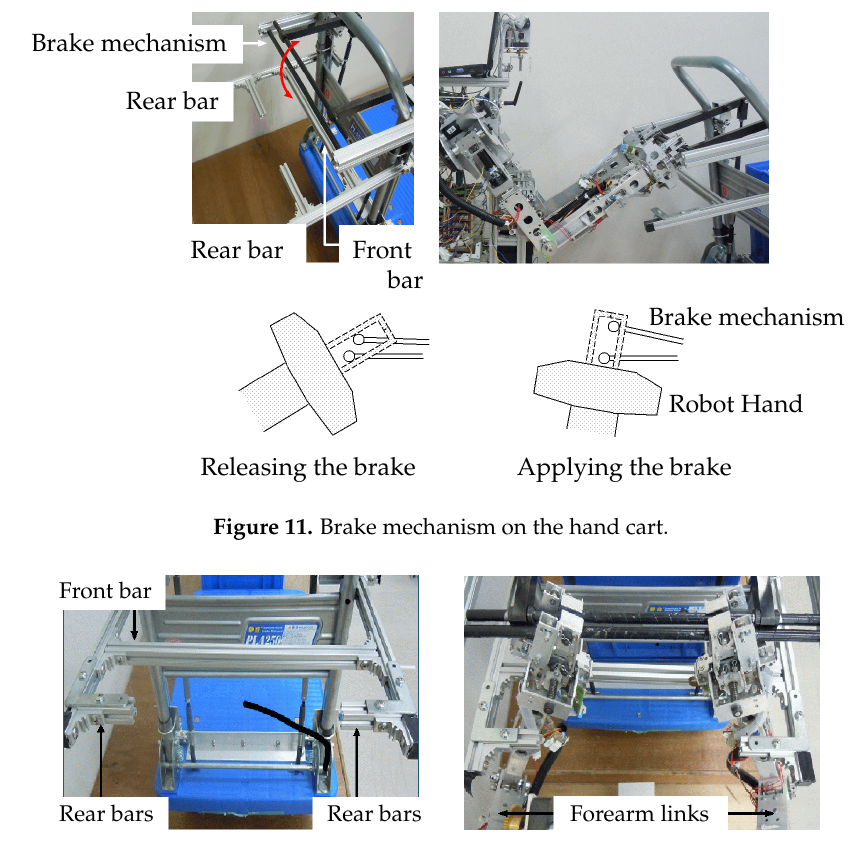
Figure 12. Stopper on the hand cart.